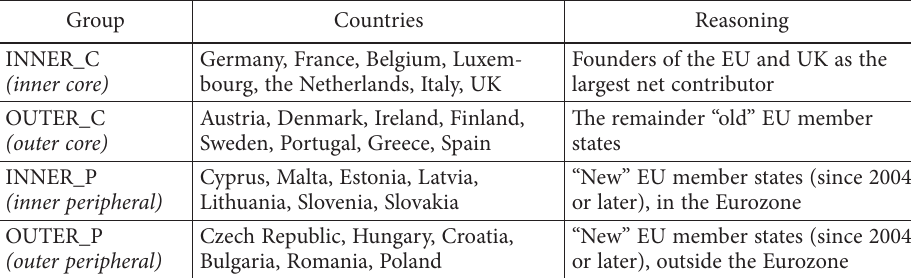
Table 1. EU member states stratification – core vs. peripheral countries